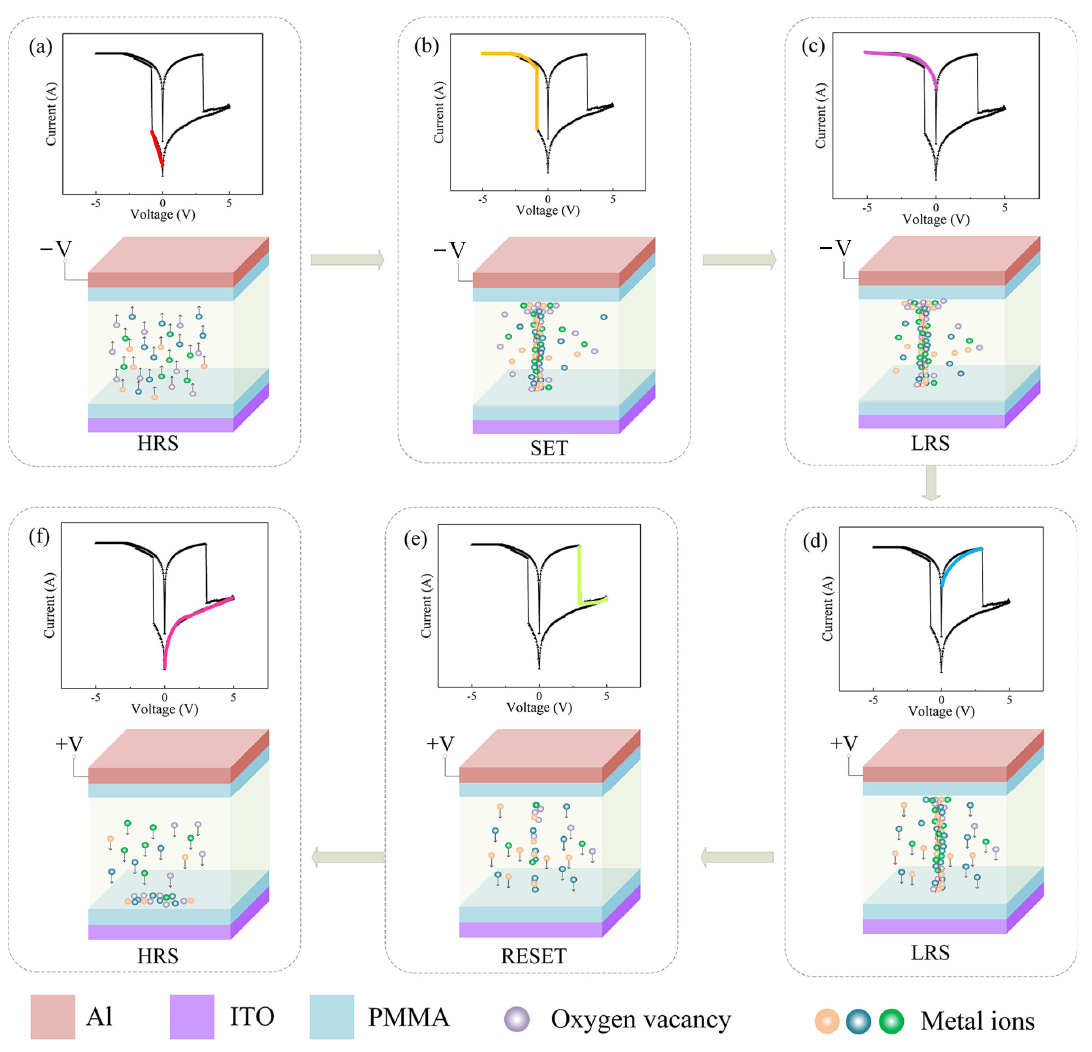
Figure 13. Conductivity diagram of the Al/PMMA/SH:GQD/PMMA/ITO device. ( a – f ) is divided into an upper and lower part: the upper part shows the IV curve of the device (different phases of the characteristic test are shown in different colors); the lower part shows the movement of oxygen vacancies and other metal ions in the dielectric layer during this phase.